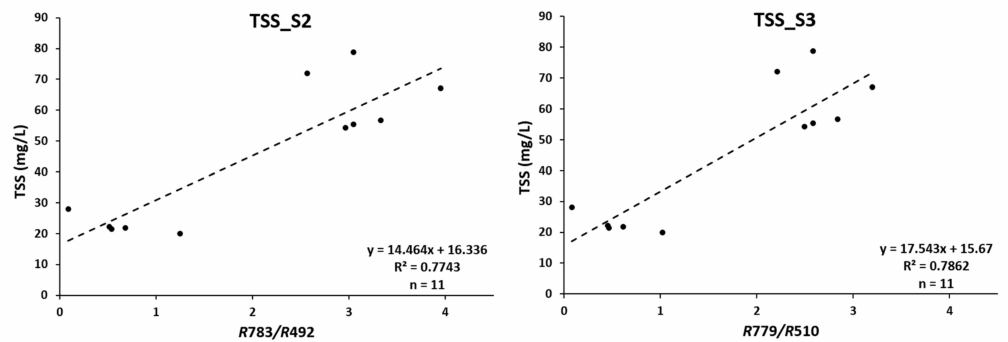
Figure 7. TSS algorithms recalculated using all data upper 20 mg/L.